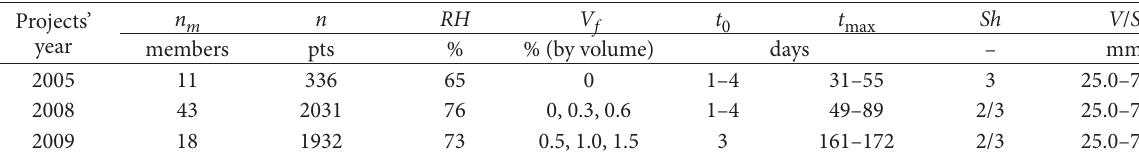
Table 3. Structure of the test data